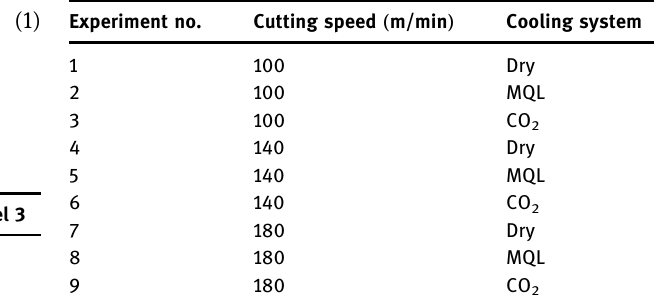
Table 3: Taguchi L9 experiment design Experiment